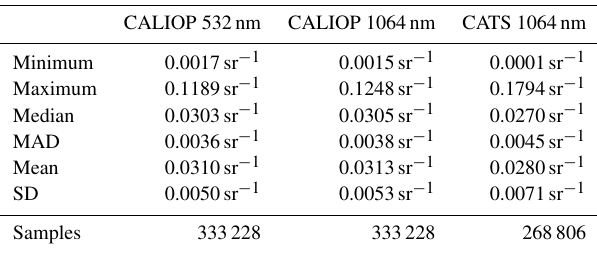
Table 2. Descriptive statistics for the integrated attenuated backscatter of opaque cirrus clouds detected during nighttime gran- ules by CATS and CALIOP during the period from 1 March to 31 December 2015 (MAD: median absolute